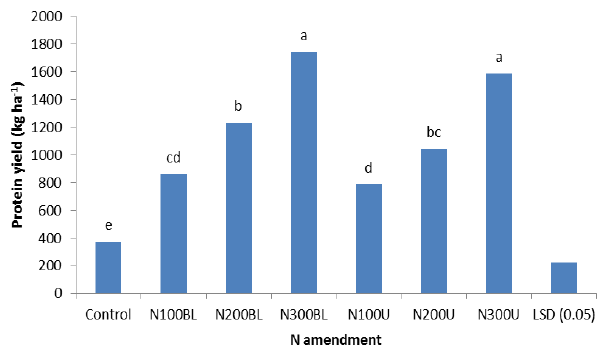
Fig. 9. The effects of N source and rate on protein yield concentration of silage corn. Means with the different letters show significant difference (LSD, P ≤ 0.05). See Fig. 2 for abbreviations